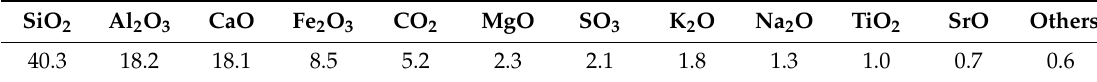
Table 4. Chemical compositions of fly ash (%).